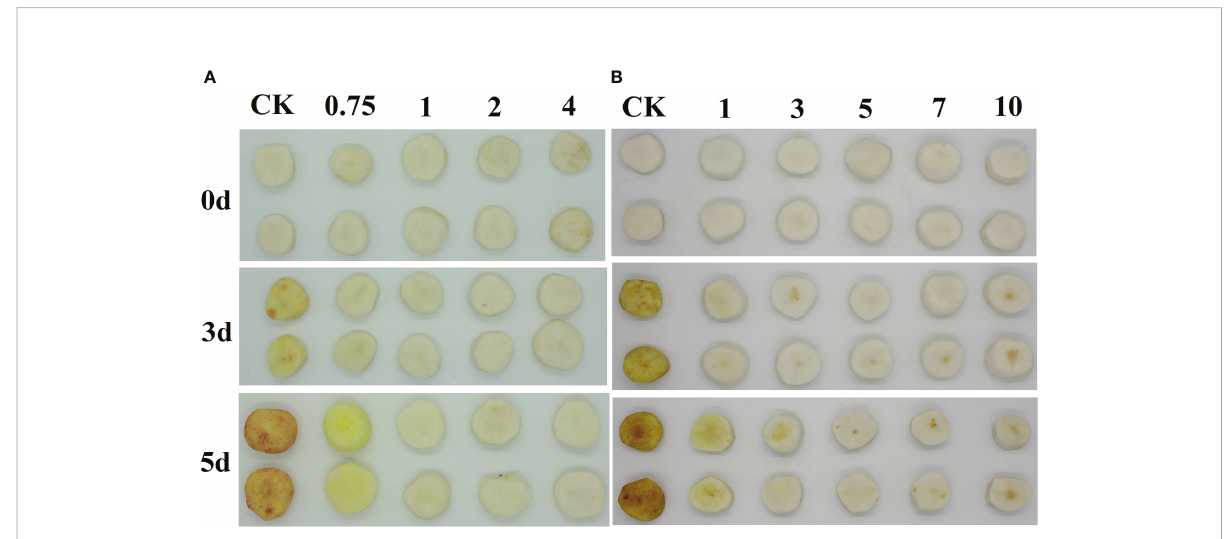
FIGURE 1 Images of 0, 0.75, 1, 2, and 4 g/L EUG treatment on fresh-peeled CWC (A) , and 0, 1, 3, 5, 7 and 10 min EUG treatment on fresh-peeled CWC (B)